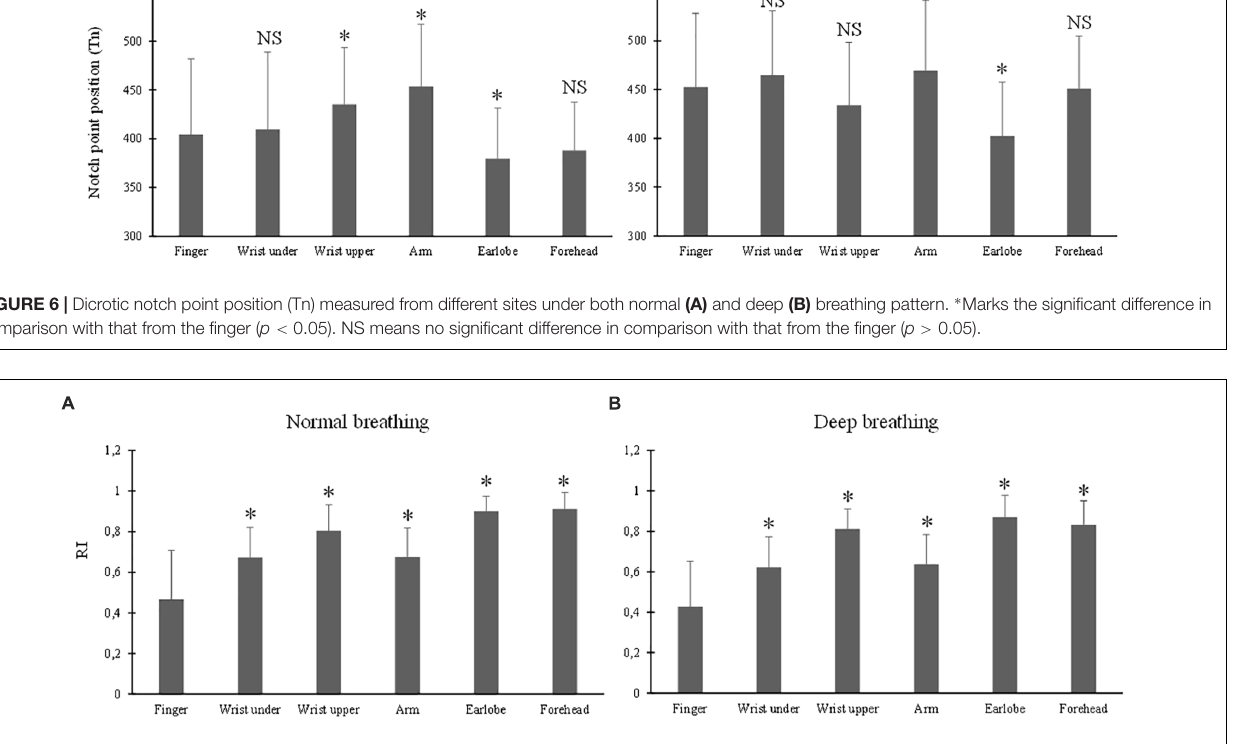
FIGURE 7 | Reflection index values measured from different sites under normal (A) and deep (B) breathing patterns. ∗ Marks the significant differences in comparison with that from the finger ( p <